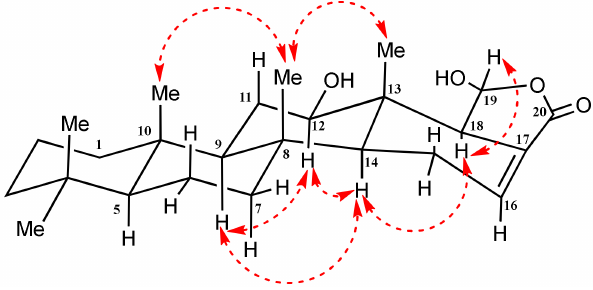
Figure 4. Important NOESY NMR correlations observed for Compound 14 .